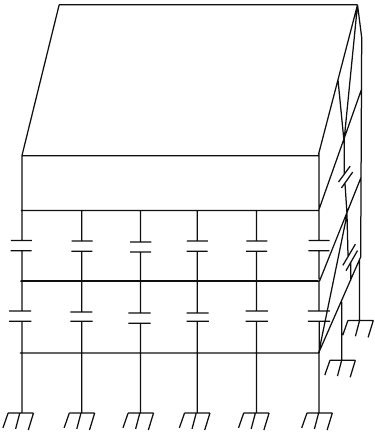
Figure 6: The torsion effect on the building is in 𝑥